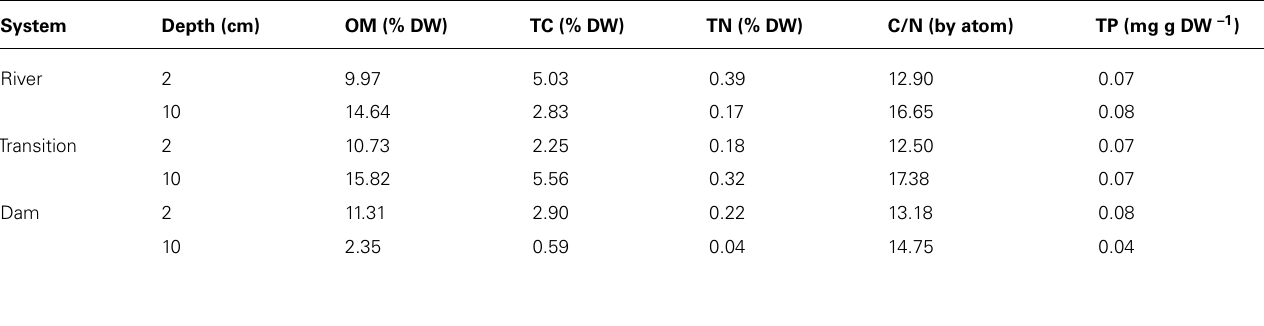
− 23.70 (middle), and − 21.10‰ (bottom). The different zones